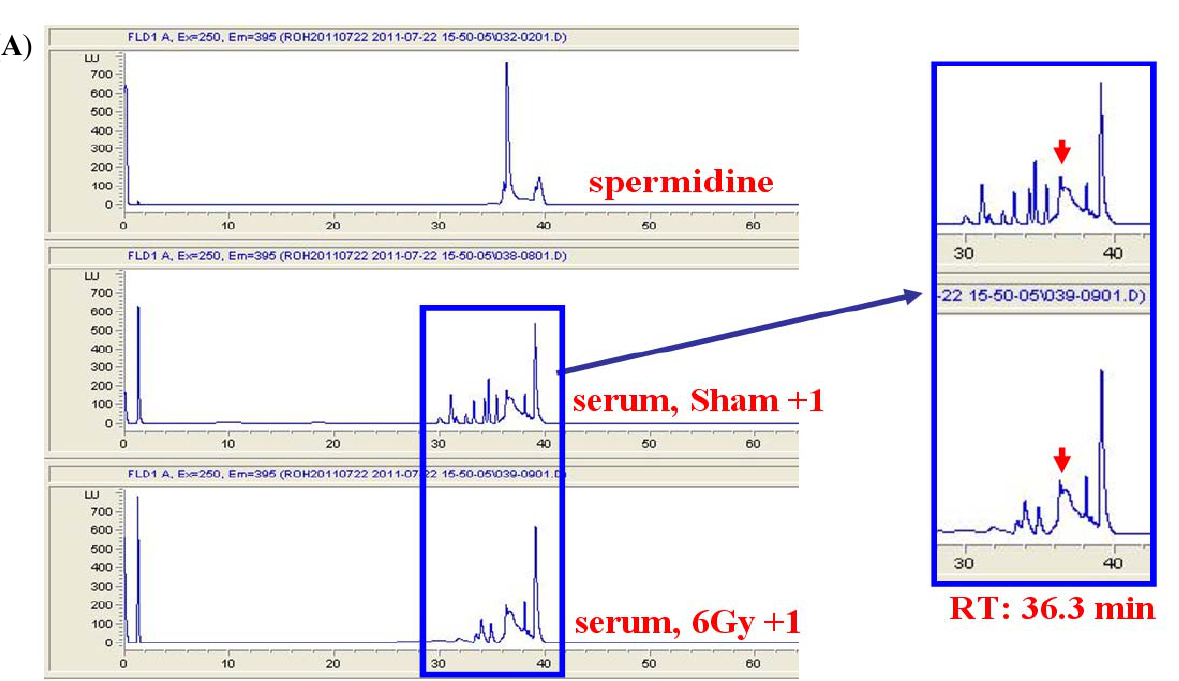
Figure 3. HPLC analysis for spermidine change ( A ) Spermidine standard curve ( B ) Spermidine concentration in the serum of sham and irradiated C57BL/6 model ( C